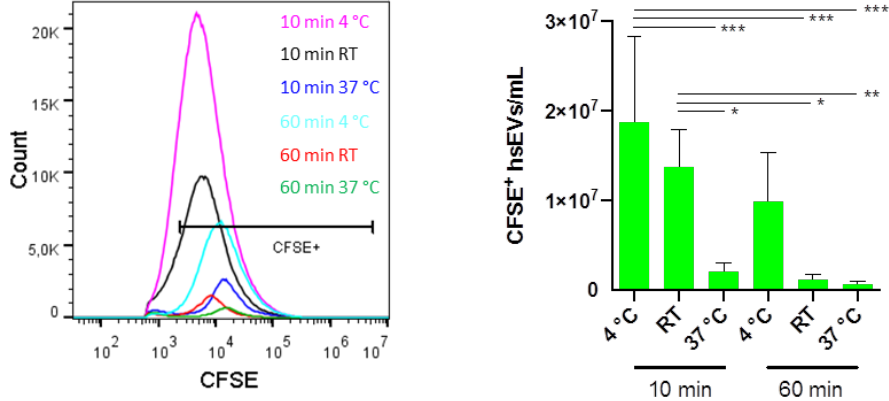
Figure 2. Optimization of CFSE-staining conditions for hsEVs. After low-speed centrifugation, the supernatant was harvested and stained with 40 µM carboxfluorescein diacetate succinimidyl erster (CFDA-SE) for 10 min or 60 min at 4 °C, room temperature (RT), or 37 °C. Samples were then centrifuged at 10,000× g for 90 min at 4 °C. Pellets were re-suspended in phosphate buffered saline (PBS). Quantification of CFSE + hsEVs was done using high-resolution flow cytometry. A representative picture for the yield of intact hsEVs depending on the incubation condition is expressed by the histogram (left). Samples were measured with a threshold of 600 for the FITC channel. Bar graph shows the mean ± SD ( n = 4) (right). Statistical analysis was done using two-way ANOVA and Tukey’s multiple comparison test. p values < 0.05 were considered statistically significant. * p < 0.05, ** p < 0.01, *** p < 0.001.